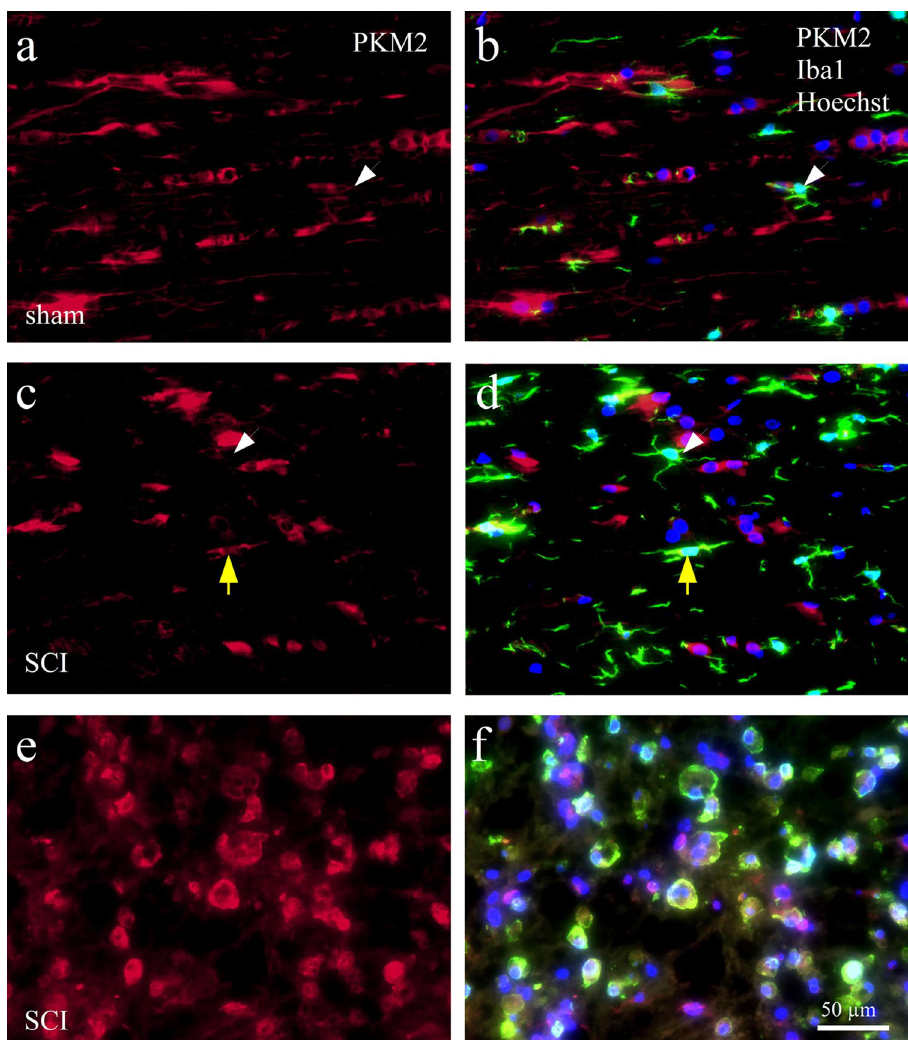
Figure 7. Immunoreactivity of PKM2 in glia cells in the rat spinal cord. IHC staining with an antibody against PKM2 (a, c, e, red fluorescence) was combined with Iba1 (green) and Hoechst nuclear stain (blue, triple labeling shown in b, d, f). (a, b) PKM2 immunoreactivity in dorsal white matter of a rat without SCI; (c, d) PKM2 staining in dorsal white matter at 4dpo and 8 mm distance from the lesion center; white arrow heads point at microglia without PKM2 staining, and yellow arrows indicate a microglia cell with nuclear PKM2 staining. (e, f) PKM2 immunoreactivity at 4dpo in the lesion center; many Iba1 positive cells display PKM2 staining in their nuclei (violet staining in f ). Scale bar in f applies to all